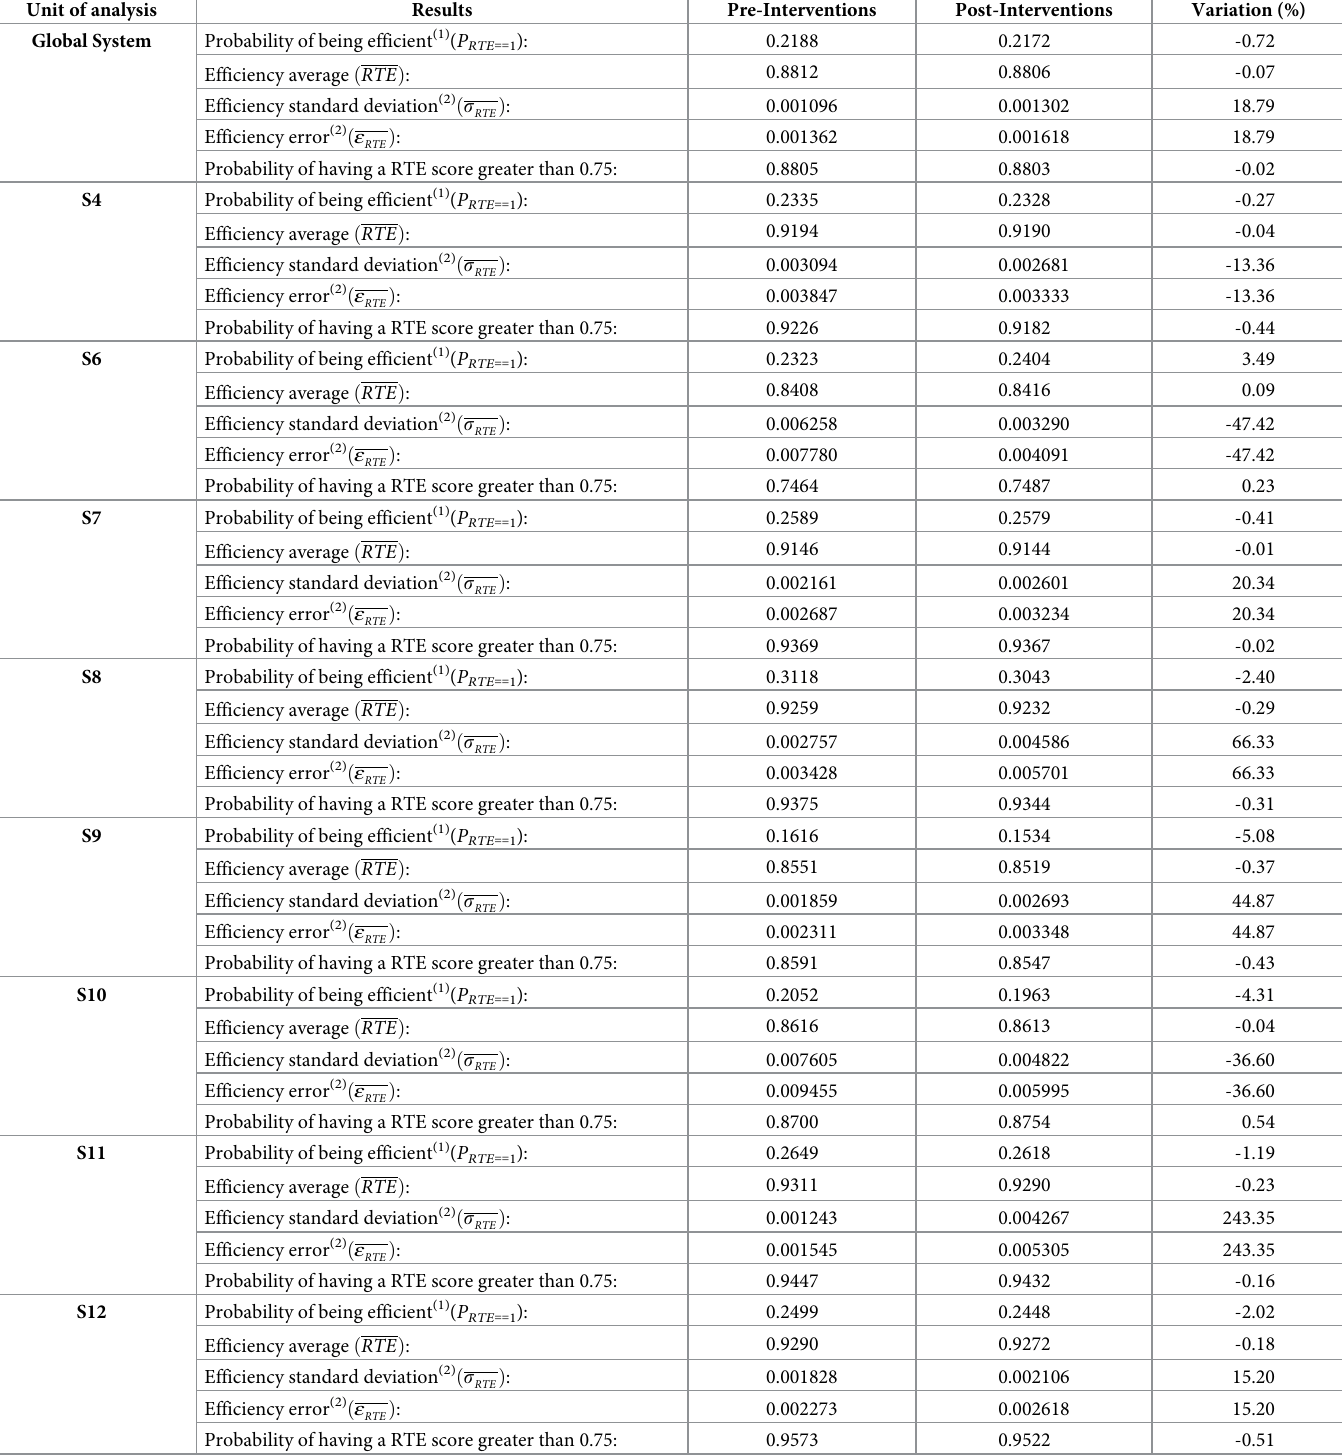
Table 4. Impact of the meso-interventions (output-oriented results). Unit of